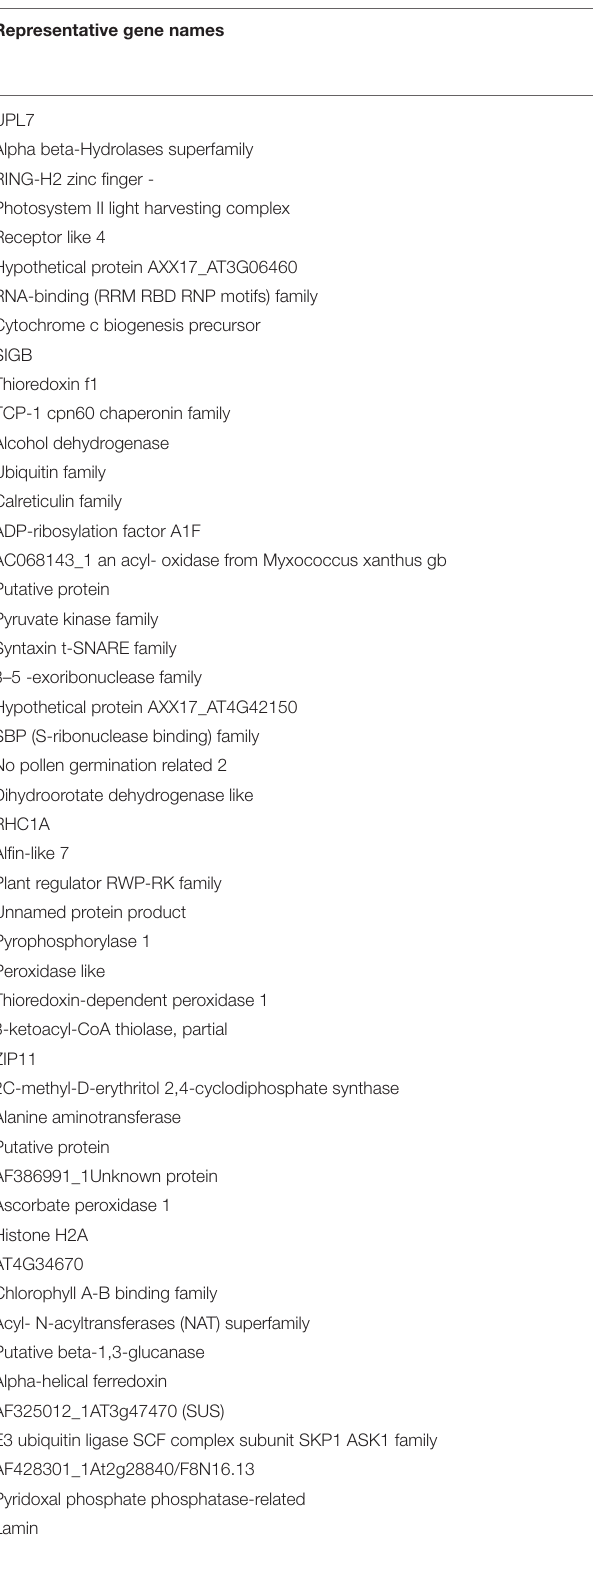
TABLE 8 | Different ESTs upregulated in “Gola” and “Surahi” cultivars under drought